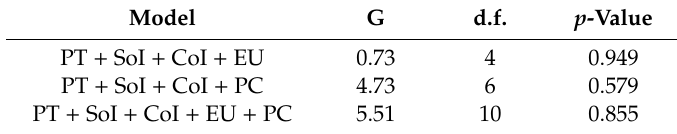
Table 4. Additive models with and without non-significant